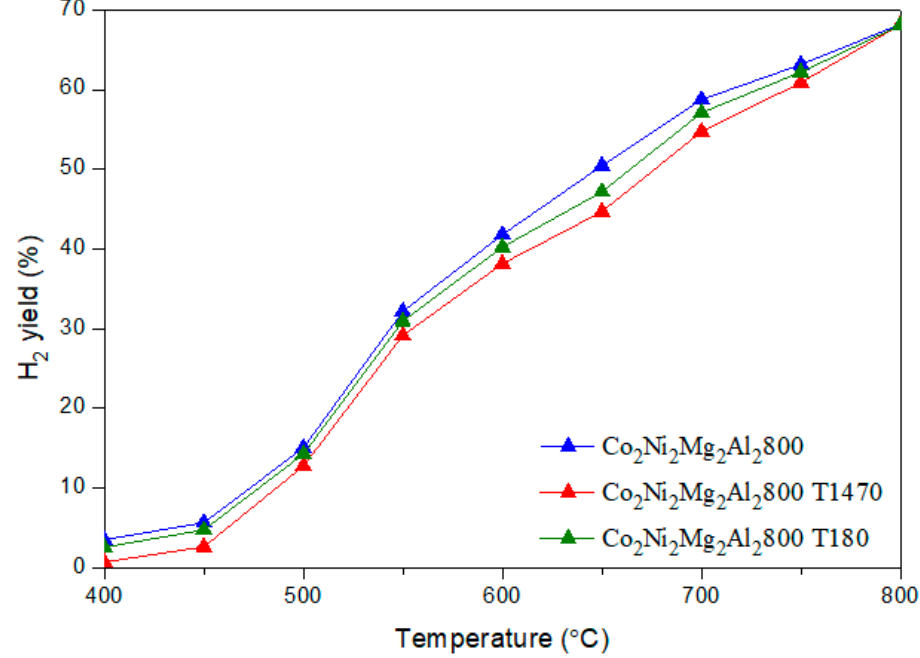
Figure 9. Evolution of the H 2 yield in DRM versus the reaction temperature for the catalyst Co 2 Ni 2 Mg 2 Al 2 800 with and without toluene.